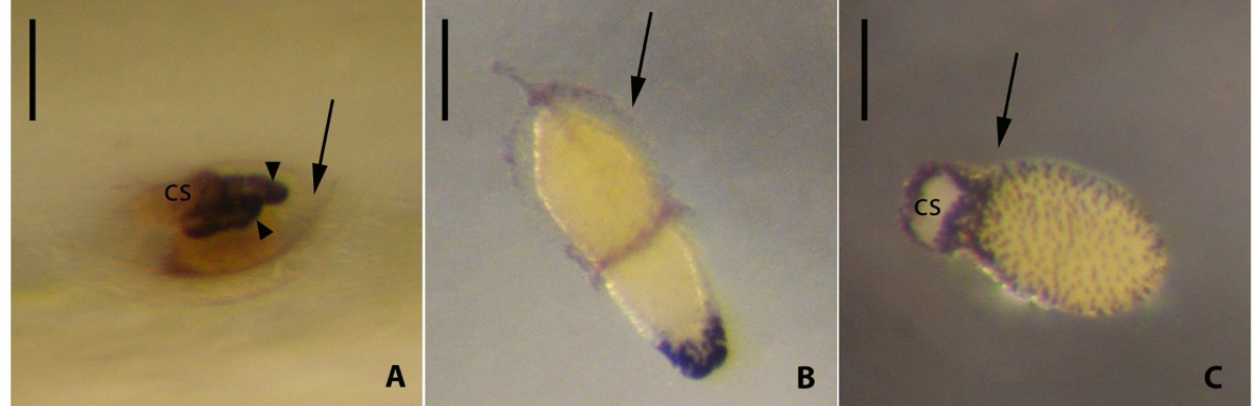
Figure 5. Rhabdopleura recondita metamorphosing larvae. ( A ) A metamorphosing larva shows the dome (arrow), arms (arrowheads), and cephalic shield (cs). ( B ) A larva started the secretion of the dome (arrow). ( C ) A furrow (arrow) between the trunk and the cephalic shield (cs) is an early sign of metamorphosis. Larvae in ( B , C ) were swimming. Scale bar 80 µm.